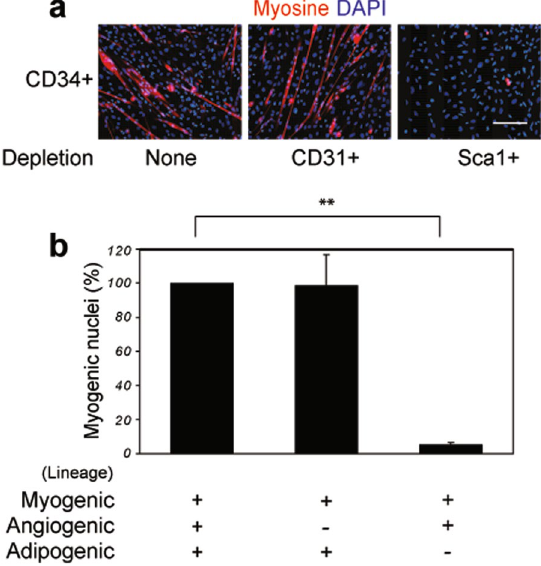
Figure 1. Adipogenic lineage cells are required for myogenic differentiation of competent cells. ( a ) Microscopic observations of the myogenic differentiation of competent cells. Cells harvested from leg muscles of 17 dpc foetuses and sorted into a CD34 + population (CD34 + /depletion none), CD34 + /CD31 − cells (CD34 + /depletion CD31 + ), and CD34 + /Sca1 − cells (CD34 + /depletion Sca1 + ), respectively. The different cell groups were cultured for 4 days and myogenic differentiation was assessed by immuno-staining using an anti-myosin antibody (My32, red), counterstained with DAPI (blue). Bar scale corresponds to 100 μ m. ( b ) Quantitative analyses of myogenic differentiation of competent cells. The percentage of myogenic differentiation was determined microscopically. Total CD34 + cell population was used as a reference and myogenic differentiation was arbitrarily estimated at 100%. Statistics: n = 3, t-test P < 0.0001 ( **